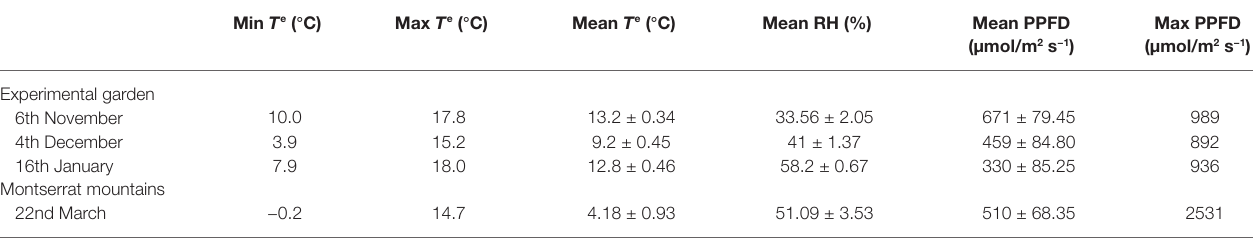
TABLE 1 | Environmental conditions during the sampling days both in the Experimental garden at the Faculty of Biology of the University of Barcelona and in the Natural Park of the Montserrat mountains.